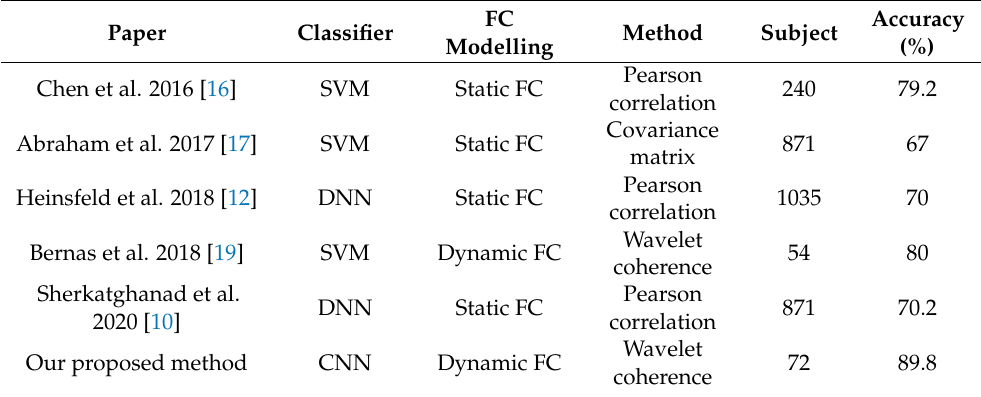
Table 6. Comparison of the proposed ASD binary classification with previous papers.